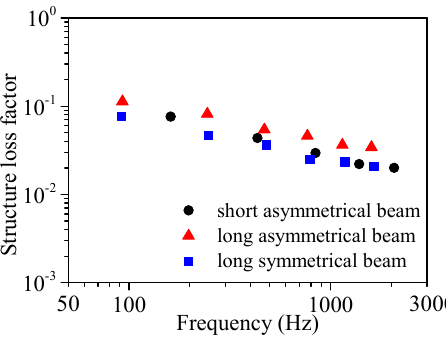
Figure 10. Test results of structure loss factors of three sandwich beam specimens.